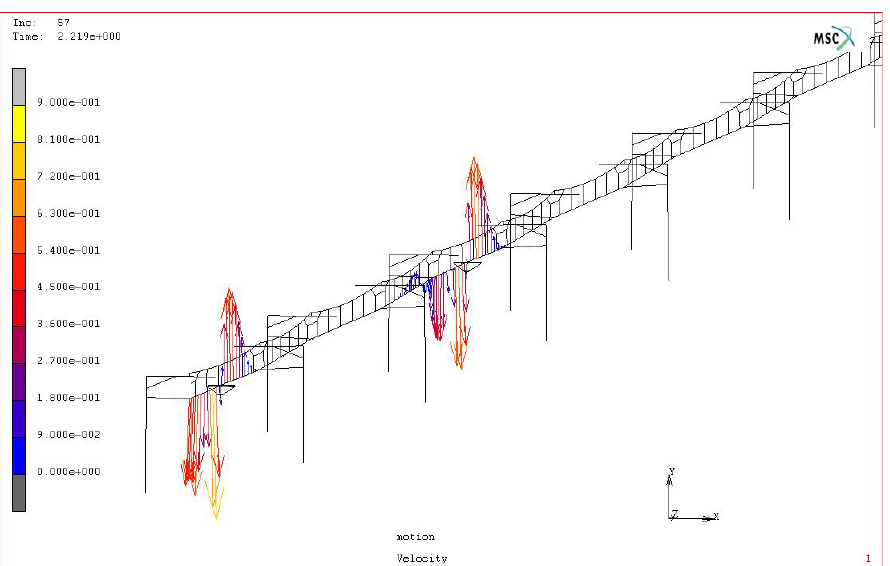
Figure 2. Pantograph-catenary system model.